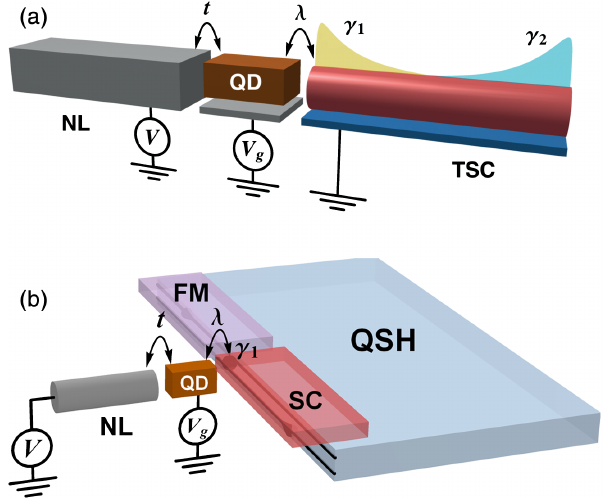
FIG. 1. Schematic picture of the device: a quantum dot coupled to a localized Majorana zero mode and a normal lead. The localized Majorana mode can be realized using (a) a 1D topological superconductor or (b) a FM-SC domain wall on the edge of a quantum spin Hall insulator. The electrochemical potential of the dot can be controlled with the gate voltage V assume that the superconductor is grounded, and one can probe the low-energy properties of the system through tunneling transport measurements. Here, V is a source-drain